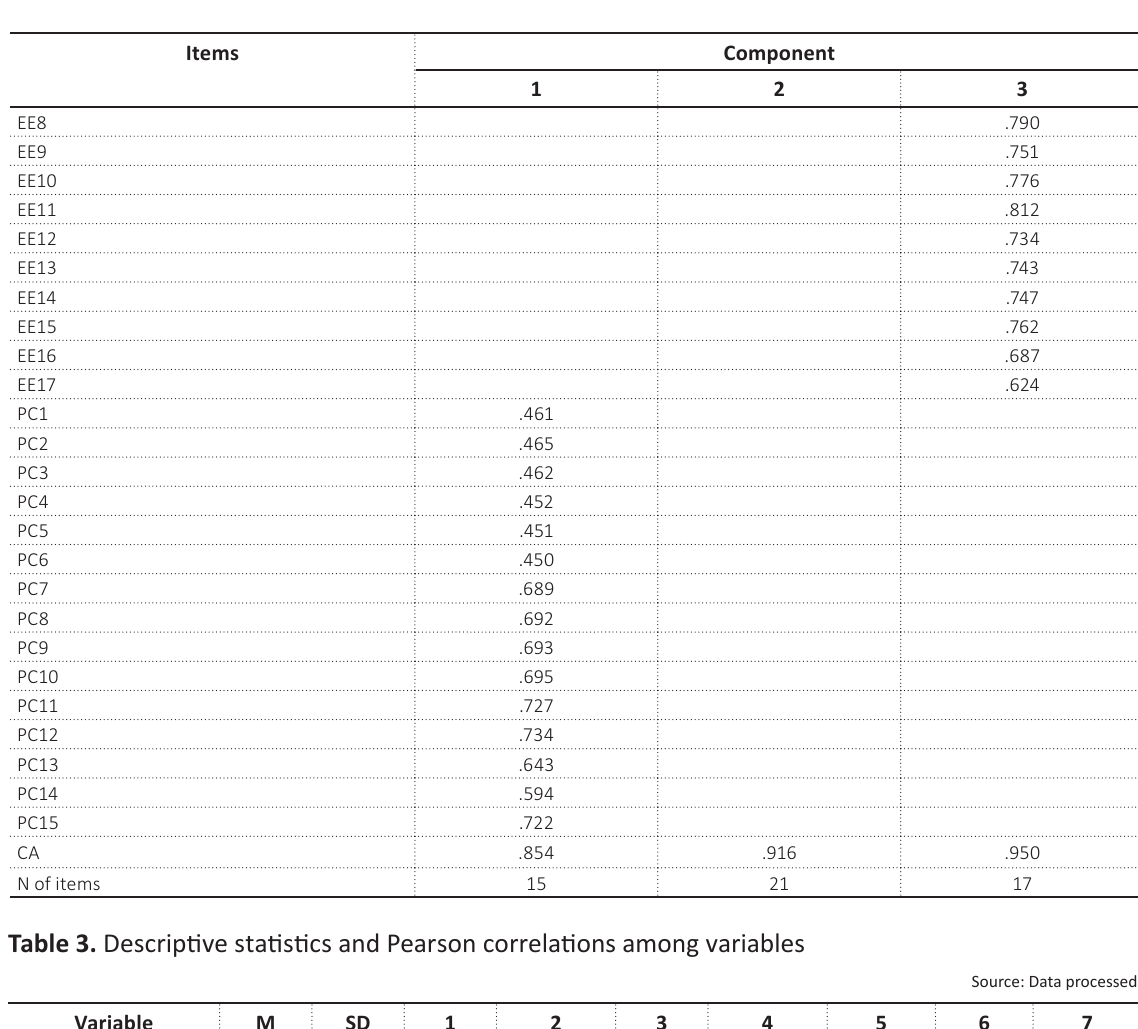
Table 2 (cont.). Validity and reliability test